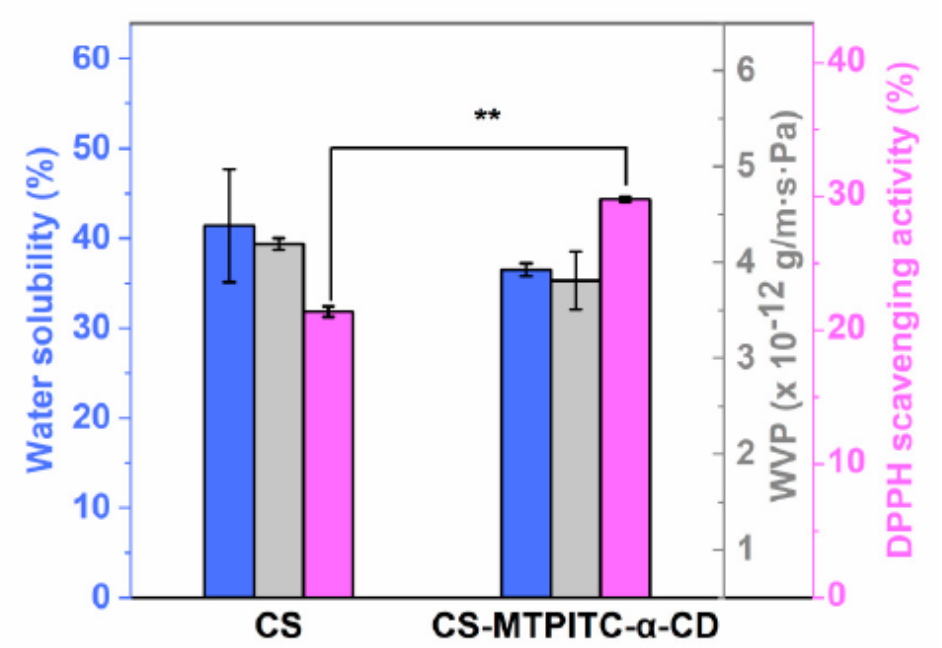
Figure 3. Water solubility (WS), water vapor permeability (WVP), and antioxidant capacity of CS and CS − MTPITC − α − CD films. ** p < 0.01 compared to the pure CS film group. Blue bars indicate WS, gray bars indicate WVP, and pink bars indicate DPPH scavenging activity.